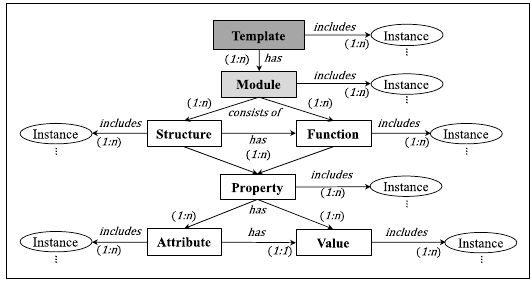
Figure 3. Entity model representation using the ontology structure.